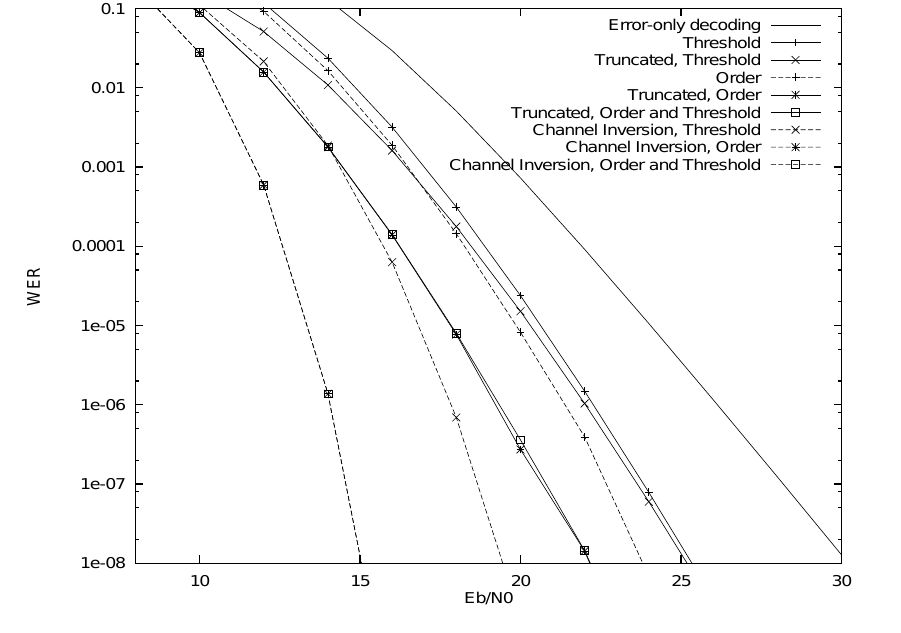
Figure 8. Comparison of WERs. Table 1. Required E b / N 0 for WER 10 − 3 and 10 − 6 .